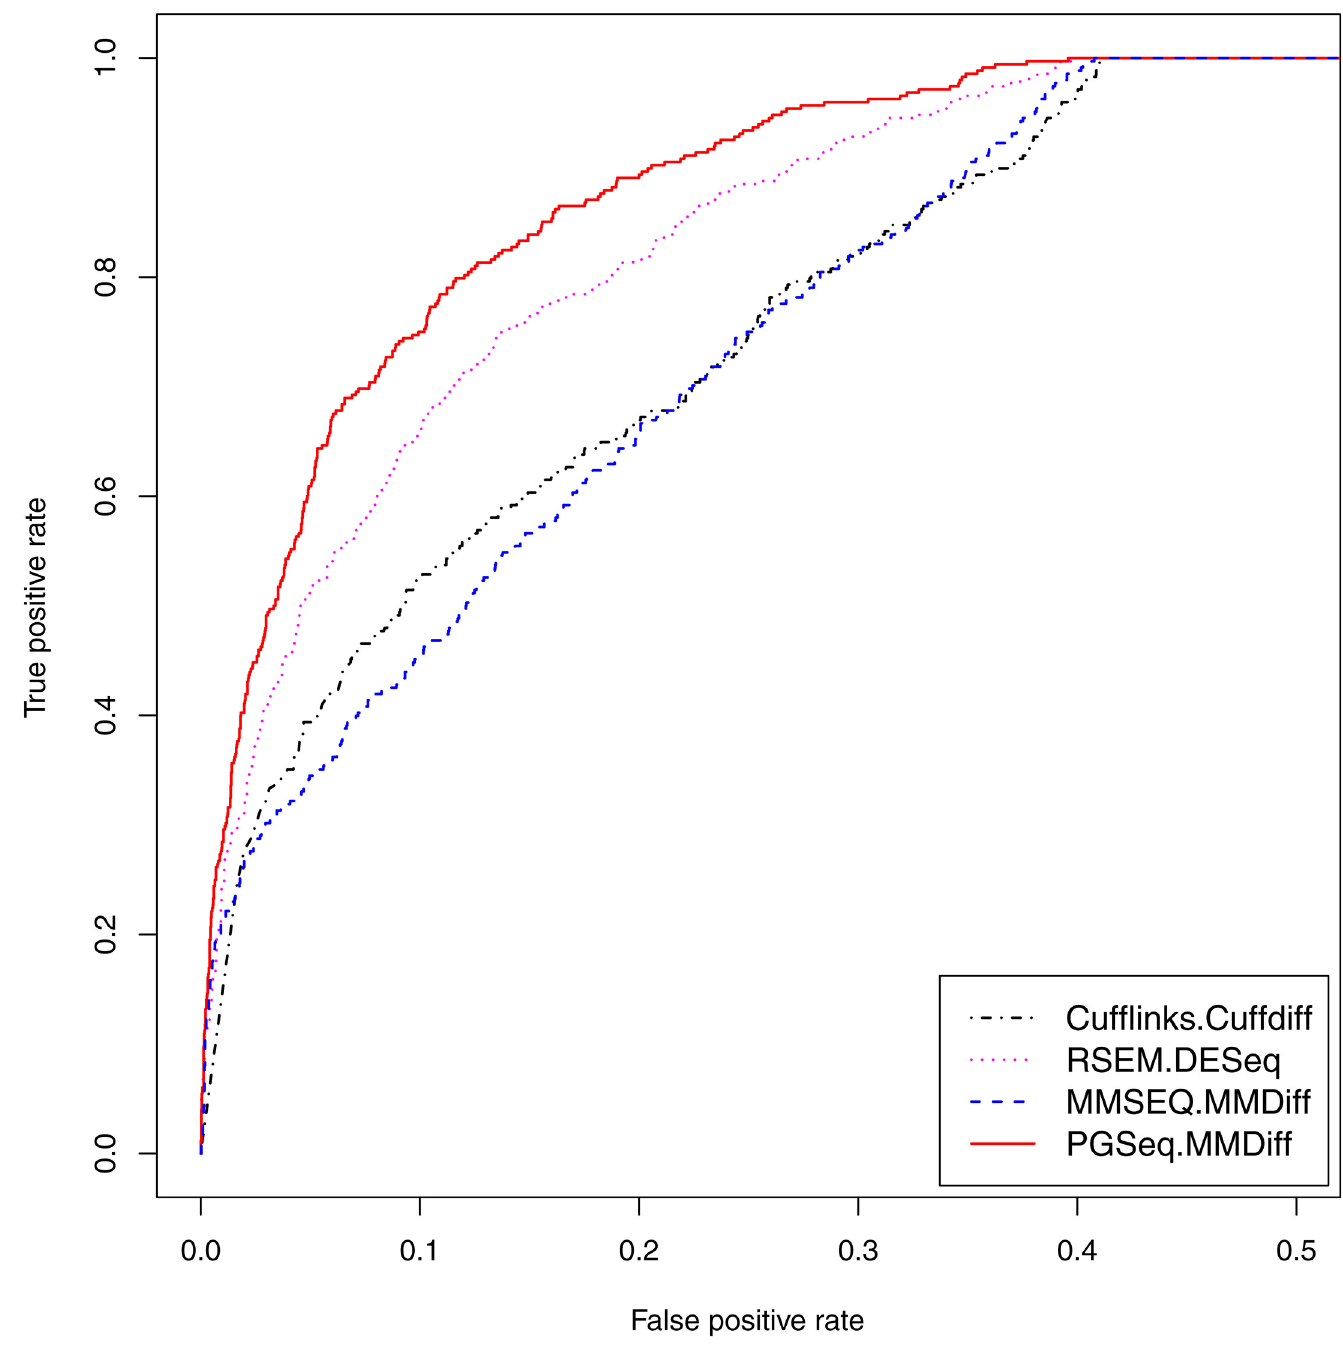
Fig 9. ROC curves of DE analysis for the lowly expressed genes in the HBD datasets. The 348 DE genes found by all the four methods are taken as the “ true ” DE genes and the rest as non-DE